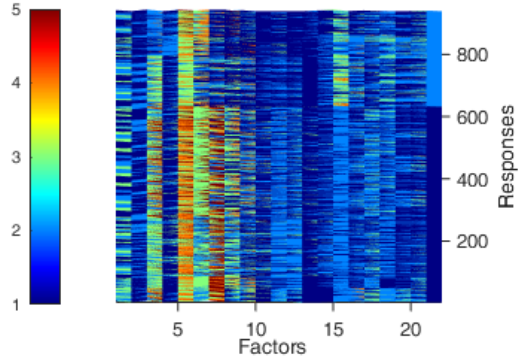
Figure 1. Heat map of 937 responses obtained from three major cities in India.